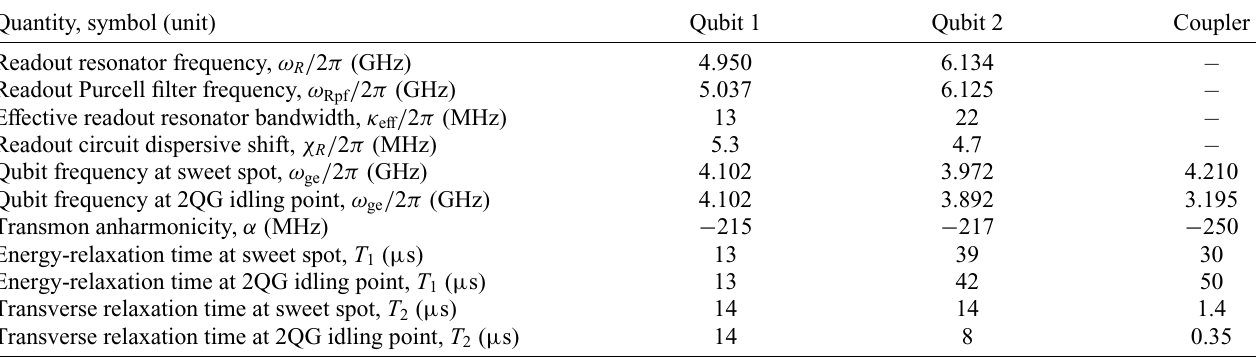
TABLE III. A summary of the device parameters. The parameters at the flux-insensitive point (sweet spot) and at the two-qubit gate (2QG) idling configurations are